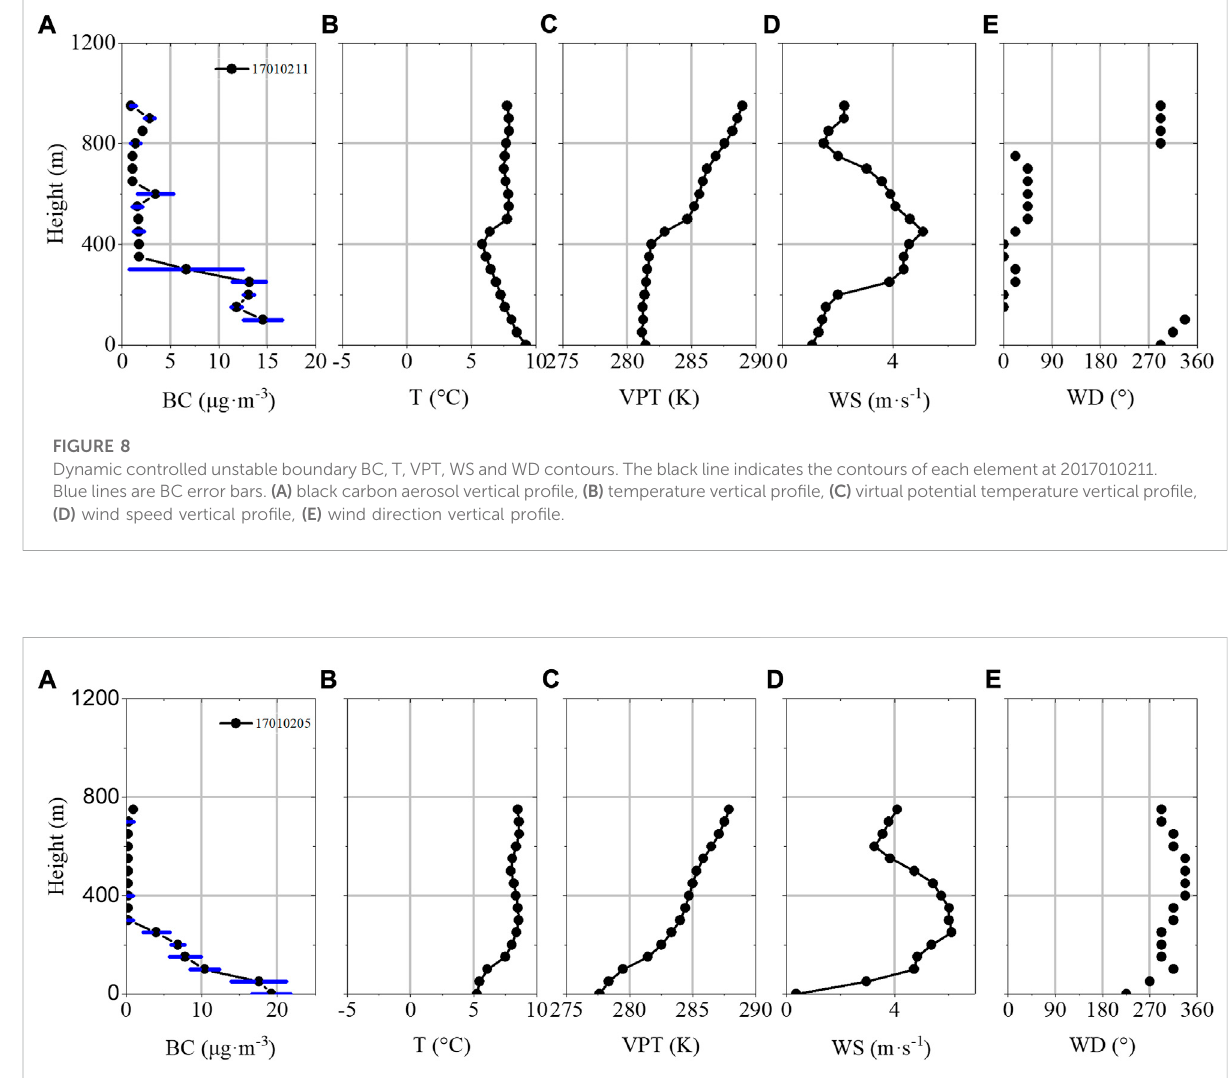
FIGURE 9 Dynamic controlled stable boundary BC, T, VPT, WS and WD contours. The black line indicates the contours of each element at 2017010205. Blue lines are black carbon error bars. (A) black carbon aerosol vertical pro fi le, (B) temperature vertical pro fi le, (C) virtual potential temperature vertical pro fi le, (D) wind speed vertical pro fi le, (E) wind direction vertical pro fi